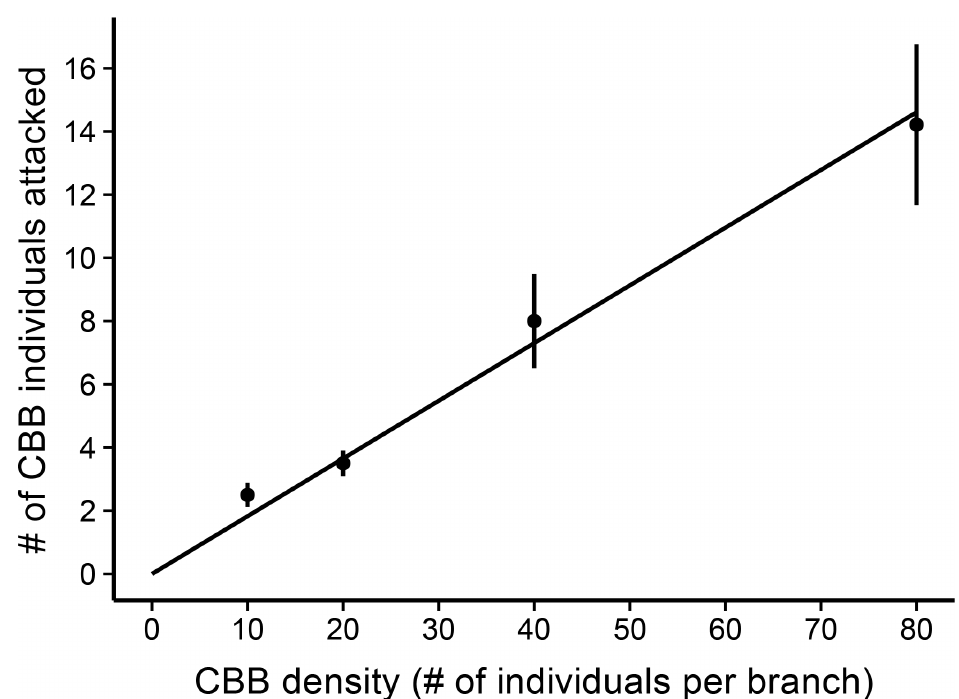
Fig 5. Functional response curve. Shows the mean number of coffee berry borer (CBB) individuals attacked by Azteca sericeasur ( ± SE) across CBB density treatments (10, 20, 40, and 80 individuals). A simple linear regression model, shown by the line, suggests a Type I functional response ( R 2 = .9948, F = 761.4, p <